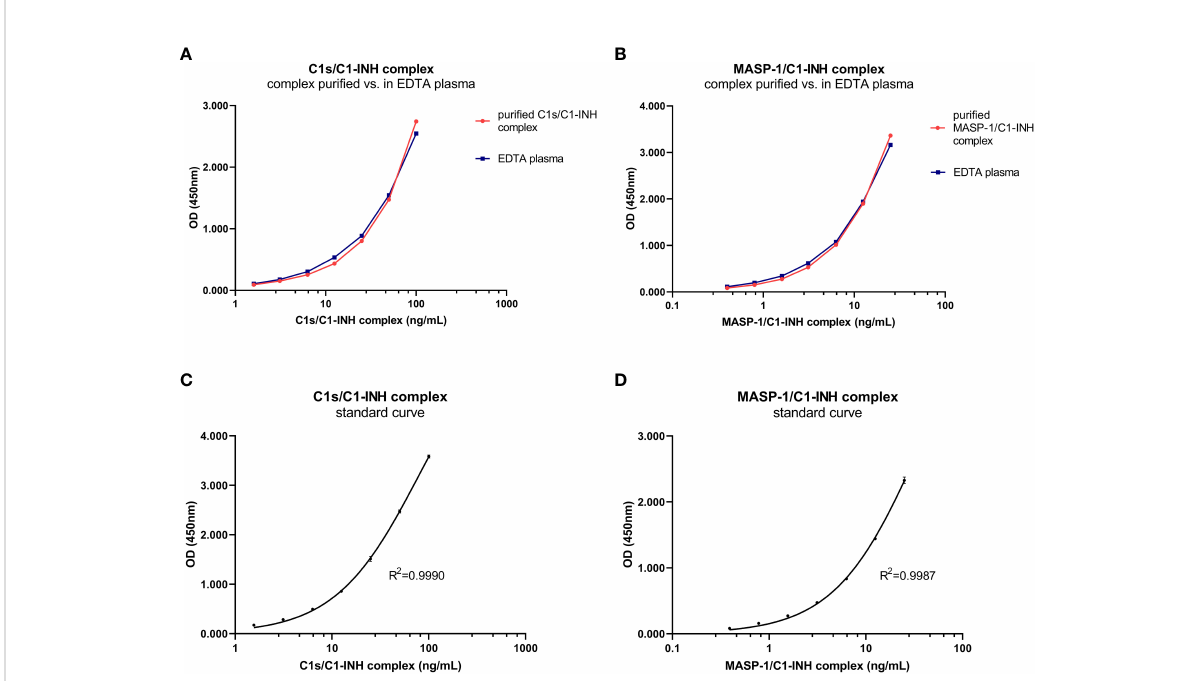
FIGURE 2 C1-INH complex standards puri fi ed in buffer and in EDTA plasma and exemplary standard curves. Parallelism of the C1-INH complexes is shown either puri fi ed in buffer (red) or in EDTA plasma (blue) for concentrations ranging from 1.6-100 ng/mL C1s/C1-INH complex (A) and 0.4-25 ng/mL MASP-1/C1-INH complex (B) . Representative results of a C1s/C1-INH complex standard curve (C) , ranging from 0 to 100 ng/mL; and a MASP-1/ C1-INH complex standard curve (D) , ranging from 0 to 25 ng/mL. The coef fi cient of determination was obtained using non-linear regression (One-site binding, Hyperbola). OD, optical density; R 2 , coef fi cient of determination; nm, nanometer; EDTA, Ethylenediaminetetraacetic